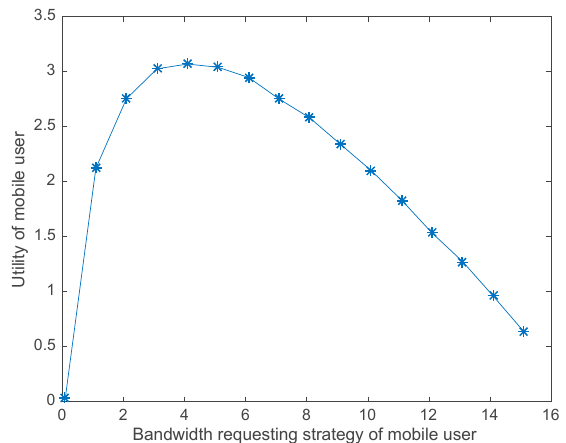
Figure 2. Utility of mobile users with the bandwidth requesting strategy.